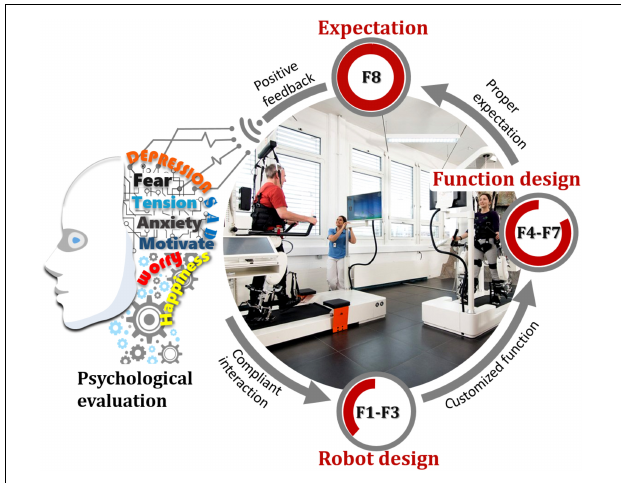
FIGURE 1 | Proposed key psychological strategies to enhance robot-assisted therapy. Picture: Hocoma,